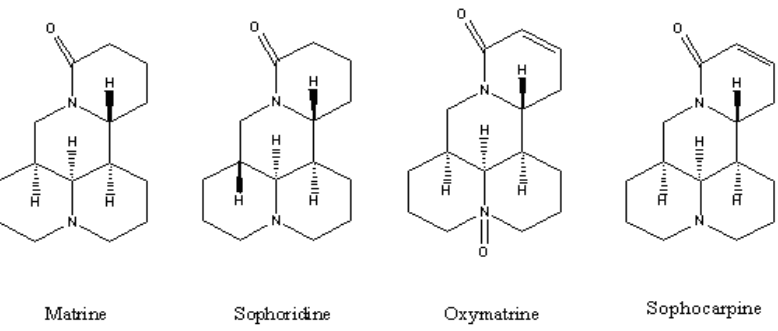
Figure 1. Chemical structure of the four